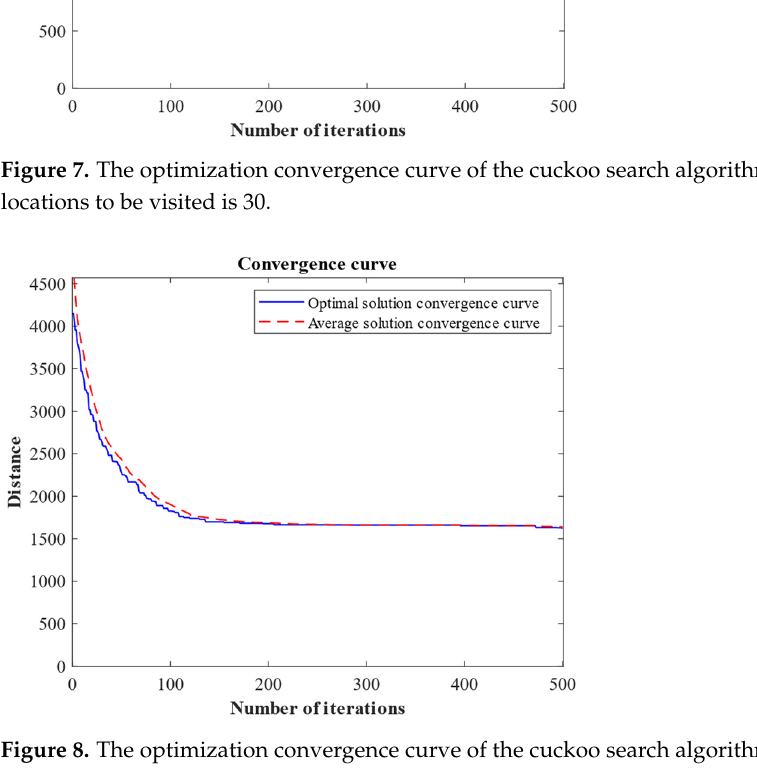
Figure 8. The optimization convergence curve of the cuckoo search algorithm when the number of locations to be visited is 40.